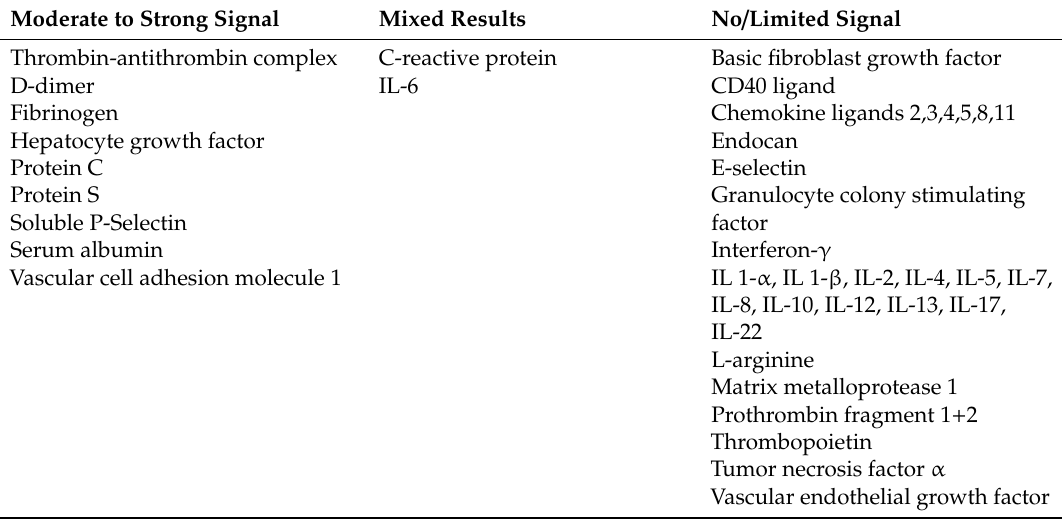
Table 4. Potential biomarkers for the diagnosis of